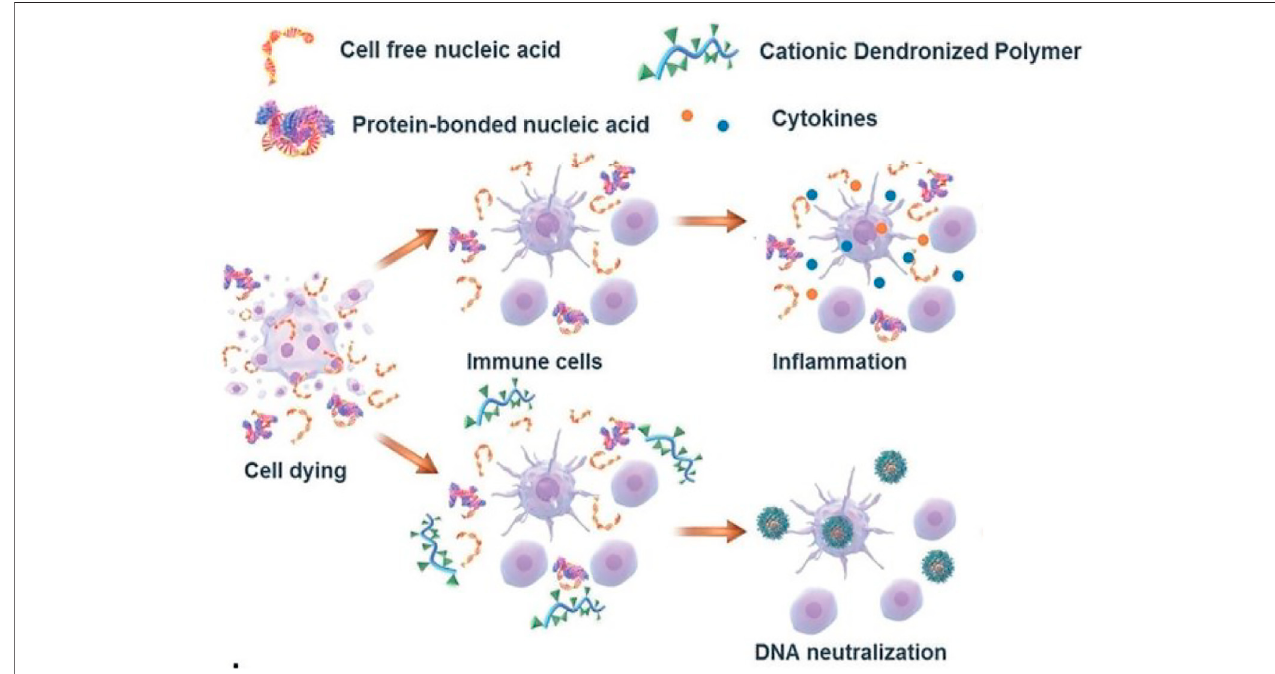
FIGURE 3 | Mechanism of cationic nanomaterials bind nucleic acids to attenuate nucleic acid-mediated activation of immune cells (Reprint from Reference (Peng et al., 2019)).